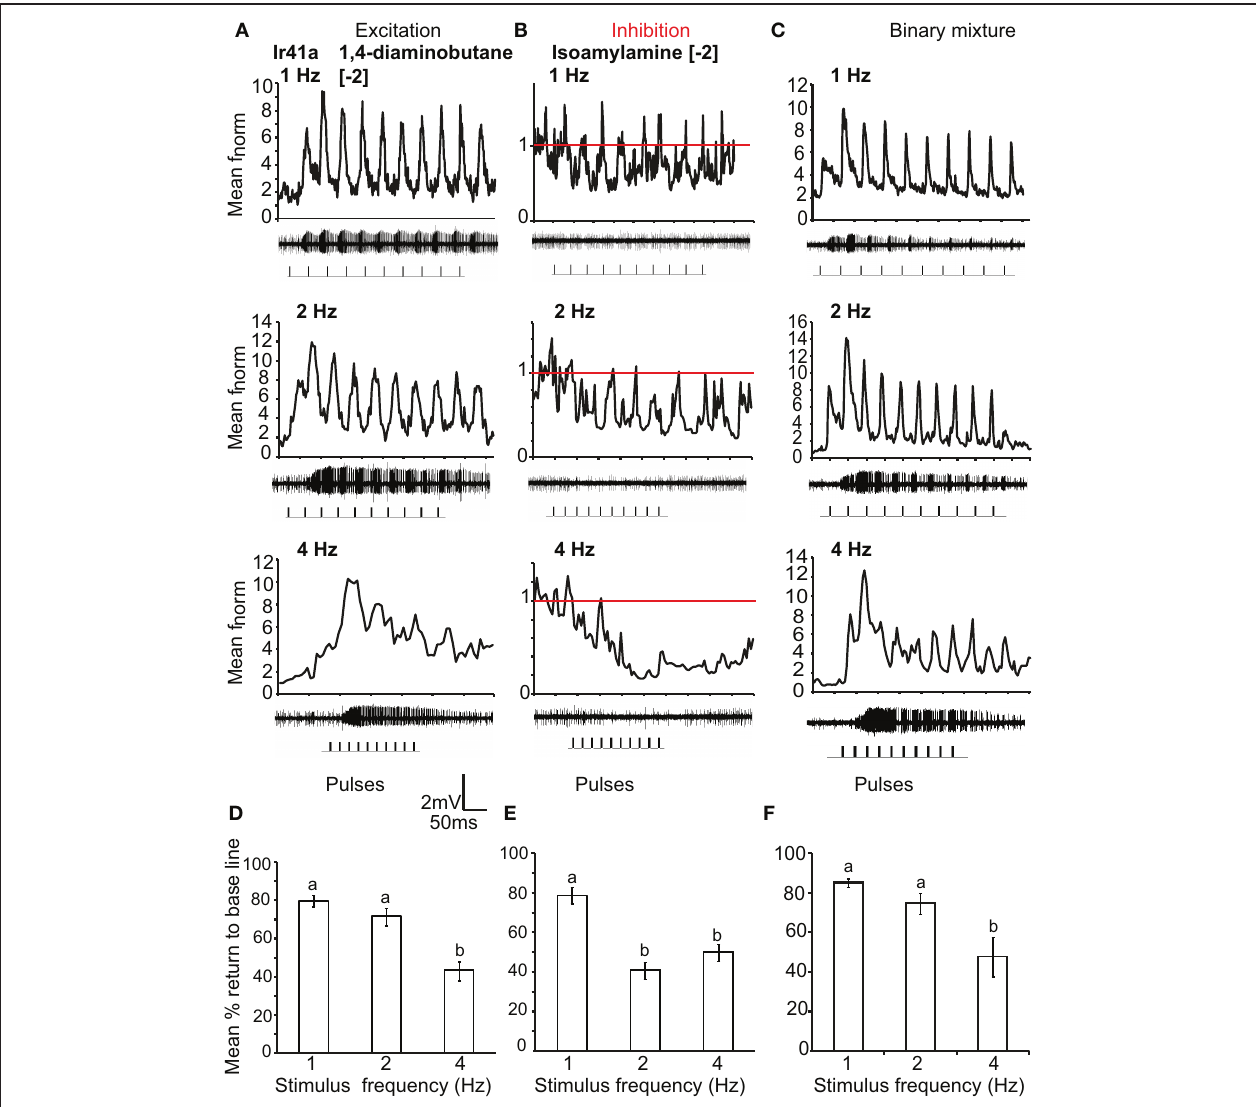
FIGURE 7 | IR-expressing OSN response polarity and pulse resolution. (A) Mean normalized PSTH response of Ir41a-expressing OSNs to repeated pulses of log [ − 2] v/v 1, 4-diaminobutane at listed frequencies. Traces below each panel show sample 50ms recordings. Square pulses indicate stimulus presentation. (B) As in (A) for log [ − 2] v/v of the inhibitory odor isoamyl amine. Red line indicates baseline frequency. (C) Mean normalized PSTH response of Ir41a-expressing OSNs to a binary